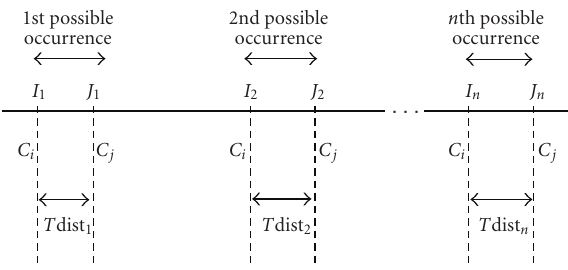
Figure 5: Two interlaced clusters with n KVDs each.